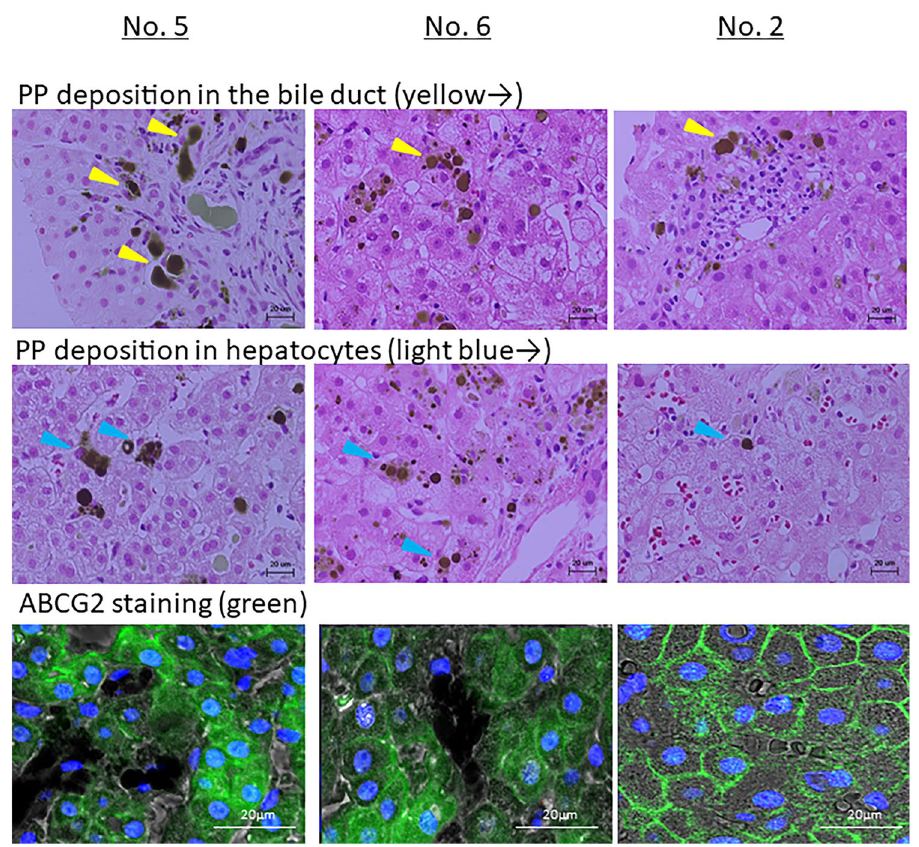
Figure 2. Hematoxylin and eosin (H&E) staining and ABCG2 staining pathology. Liver biopsy was performed in four patients, and the Maltese cross was confirmed in all patients. Biopsy samples were subjected to H&E and ABCG2 staining.